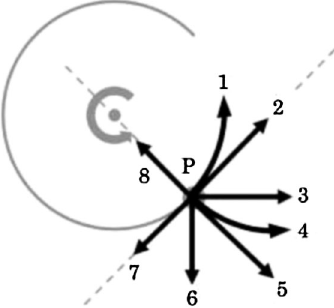
FIG. 2. Subquestions of the FCI Q.7. [Question statement] Which of the eight choices best represents the direction of the following variables, just after the string breaks? If you think a variable is zero or not at all horizontal, write 9; 1. force acting on the ball; 2. velocity of the ball.